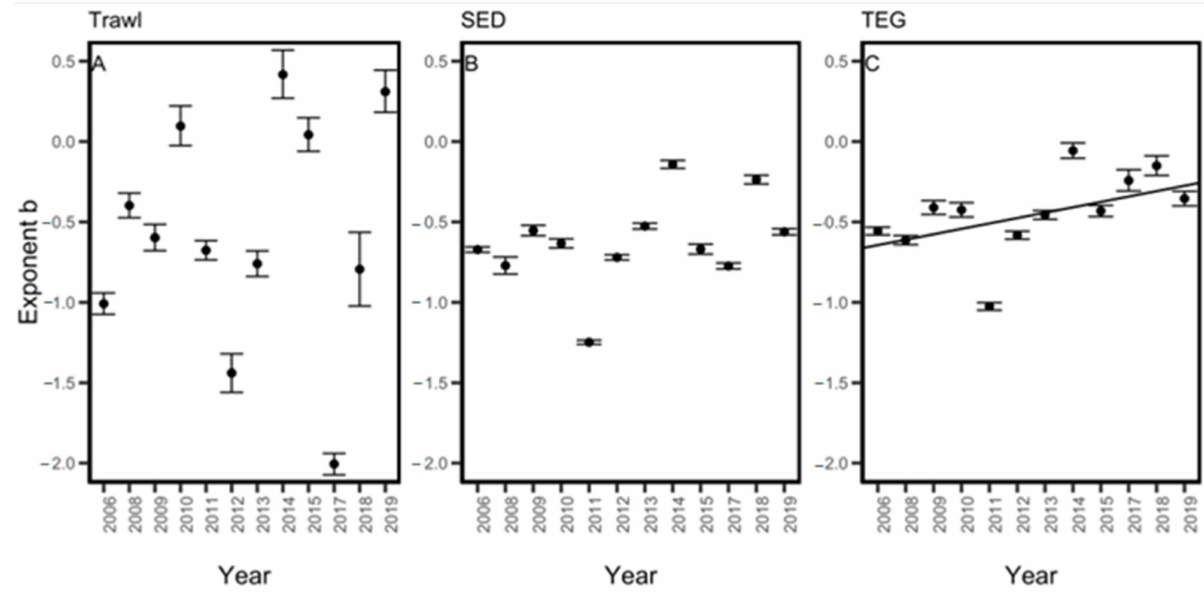
Figure 4. Size spectrum exponents b with lower and upper bounds of the 95% confidence interval of b indicated with error bars for trawling ( A ) and hydroacoustic single-echo detections (SED) ( B ) and tracked-echo groups (TEG) with a linear regression line from a weakly significant trend ( C ) to check for a temporal change in size distributions of fish between 1 and 50 g body weight for survey years between 2006 and 2019 (excluding 2007 and